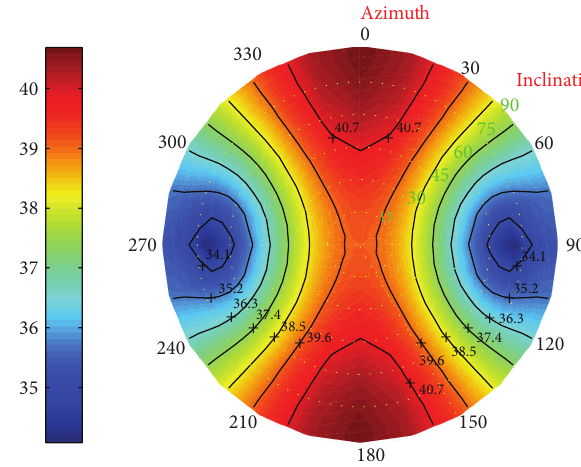
Figure 23: Risk distribution of collapse pressure when permeability coefficient is 0.5.